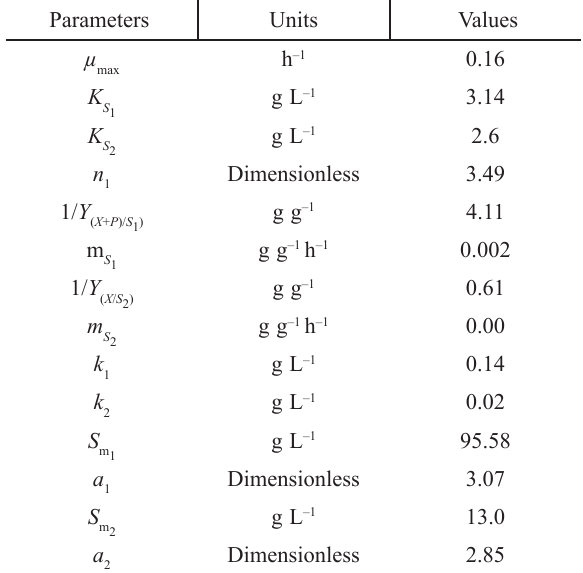
Table 6 – Optimized value of the model parameters for PHB fermentation process by C.